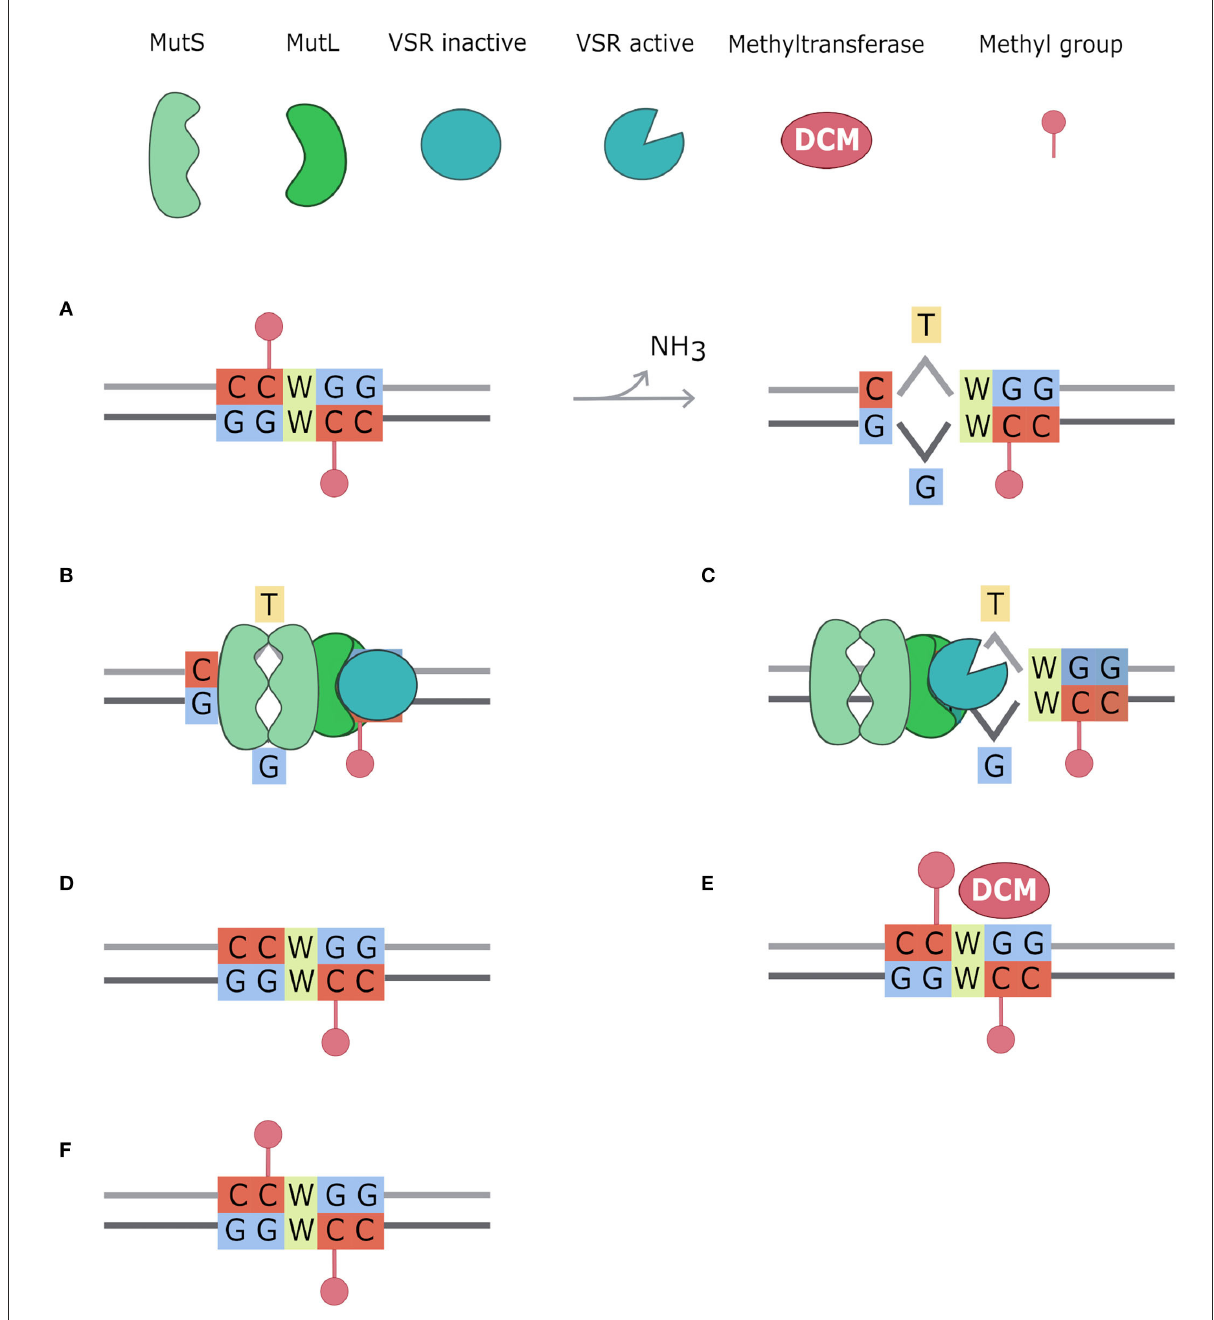
FIGURE6 Very Short Patch repair system (VSP). Methylated cytosines spontaneously deaminate to Thymine creating T/G mismatches. The very short patch repair system (VSP) acts repairing these mismatches, always in favor of the Guanine (Drotschmann et al., 1998; Marinus, 2012). In this figure, the VSP system mechanism is divided into six steps: (A) CCWGG motifs are methylated on both strands by the Dcm enzyme. Methylated cytosines spontaneously deaminate to thymine, creating a mismatch with guanine; (B) MutS dimer recognizes the mismatch and binds MutL dimer which acts as a bridge with VSR protein; (C) VSR is activated by the MutSL complex and creates a nick in the strand containing the incorrect base, using as parental stand that containing the Guanosine; (D) the MutSL-VSR complex recruits DNA helicase, exonuclease, DNA polymerase, and DNA ligase to fix the mismatch; (E) CCWGG motif is restored and thus DCM methyltransferase can methylate it; (F) CCWGG is methylated on both